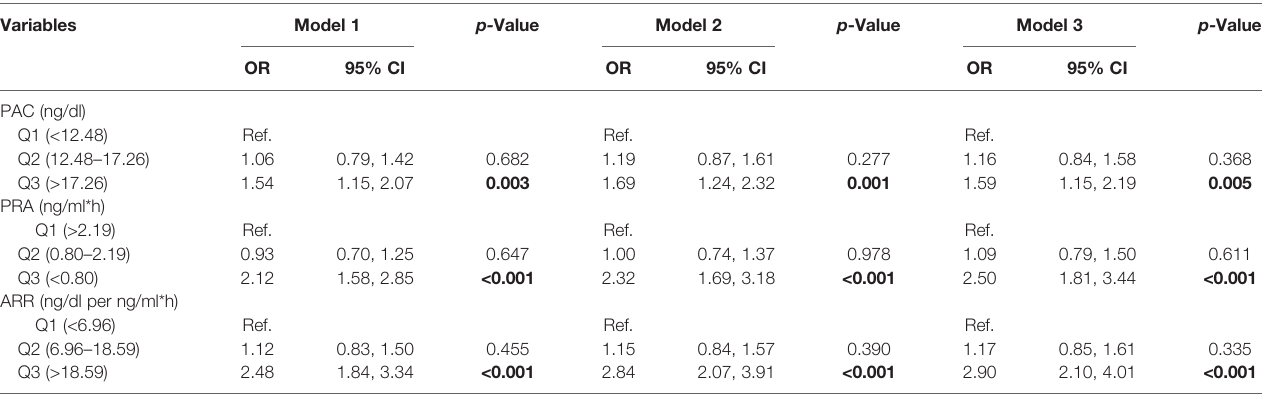
TABLE 2 | The relationship of PAC, PRA, and ARR with the risk WMLs in logistic regression analysis. Variables